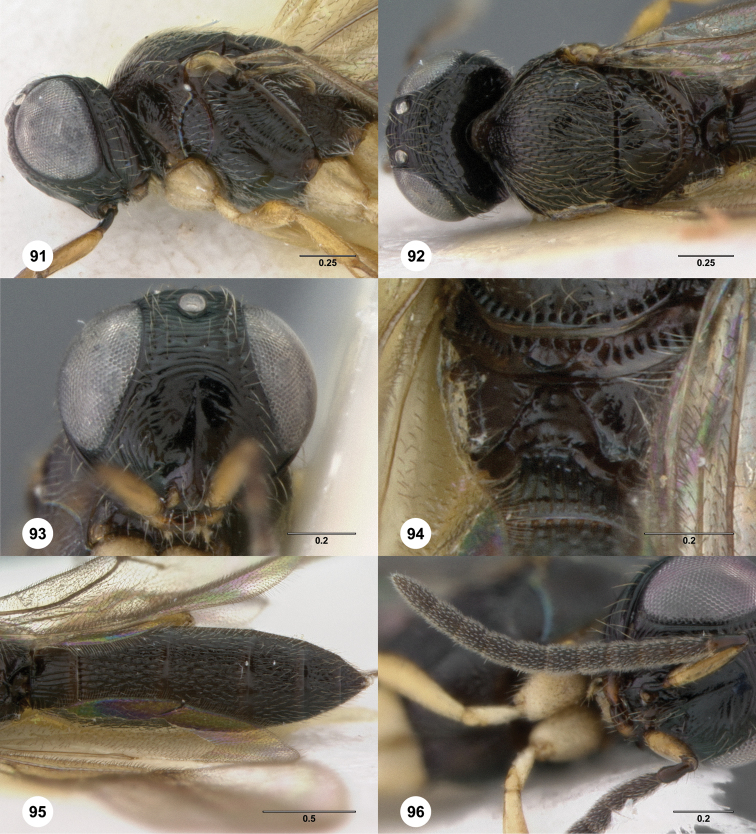
Oxyscelio divisionis sp. n., holotype female (OSUC 368204) 91 Head and mesosoma, lateral view 92 Head and mesosoma, dorsal view 93 Head, anterior view 94 Propodeum, posterodorsal view. Paratype male (OSUC 368205) 95 Antenna 96 Metasoma, dorsal view. Morphbank45